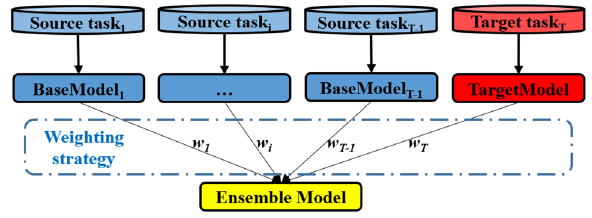
Fig. 5 Ensemble model